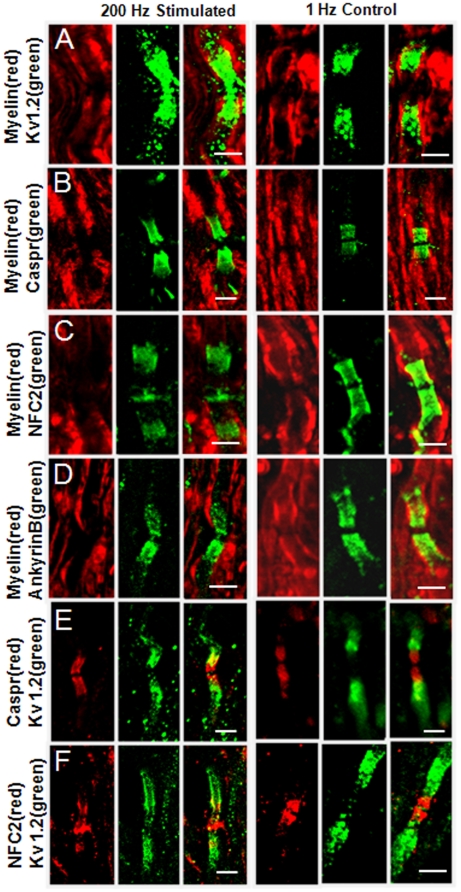
Distribution of paranodal junction and cytoskeleton proteins after 200-Hz stimulation compared with the 1-Hz stimulation group.(A) Kv 1.2 diffuses into the nodal area. (B) Caspr remained in the paranodes. (C) NF155 elongated and extended beyond paranodes while NF 186 retained. Both NF155 and NF 186 were labeled by the NFC2 antibody. (D) AnkyrinB remained in paranodes. (E) Partial overlap of Kv 1.2 and Caspr after 200 Hz stimulation (Fig. 4E) confirms the diffusion of Kv1.2 beyond the juxtaparanodal area. (F) Partial overlap of immuno-labeled NFC2 and Kv 1.2 confirms their redistribution. Bar = 5 µm for all images.